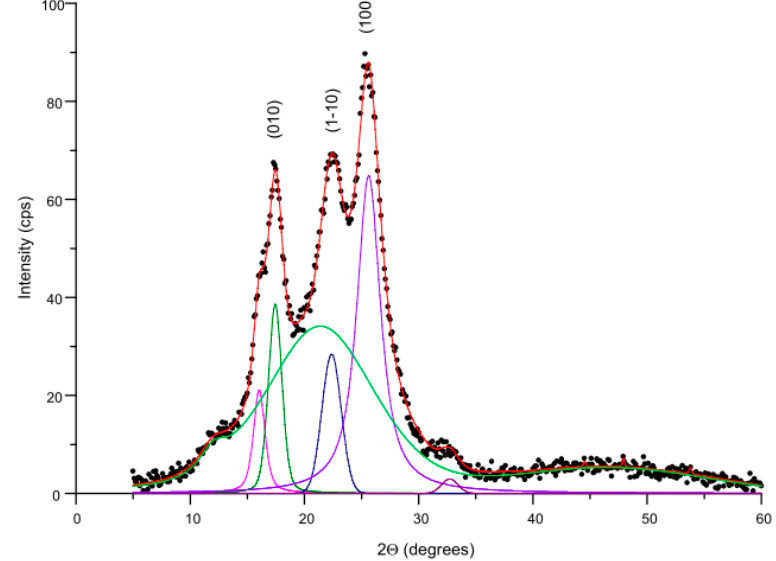
Figure 13. Deconvolution of the exemplary WAXS curve obtained for PET 130 + 7.5% C15A fibers.